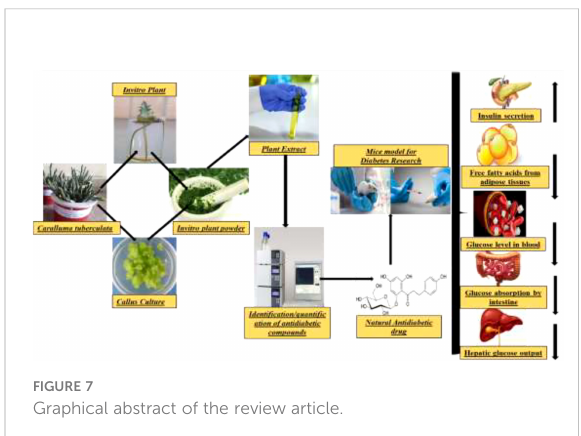
FIGURE 7 Graphical abstract of the review